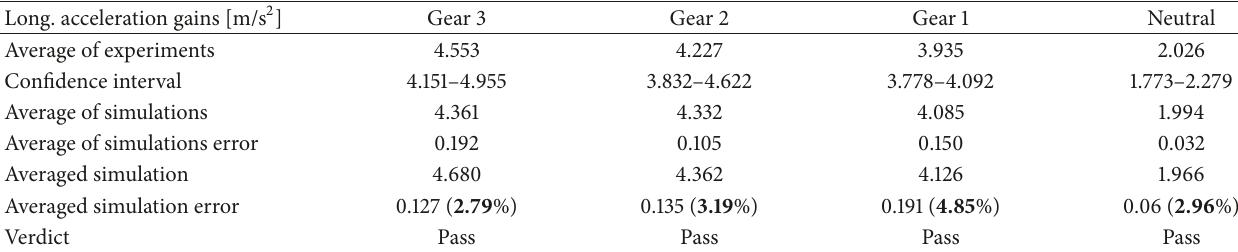
Table 9: Validation results Maneuver Long Ic: long acceleration gains.